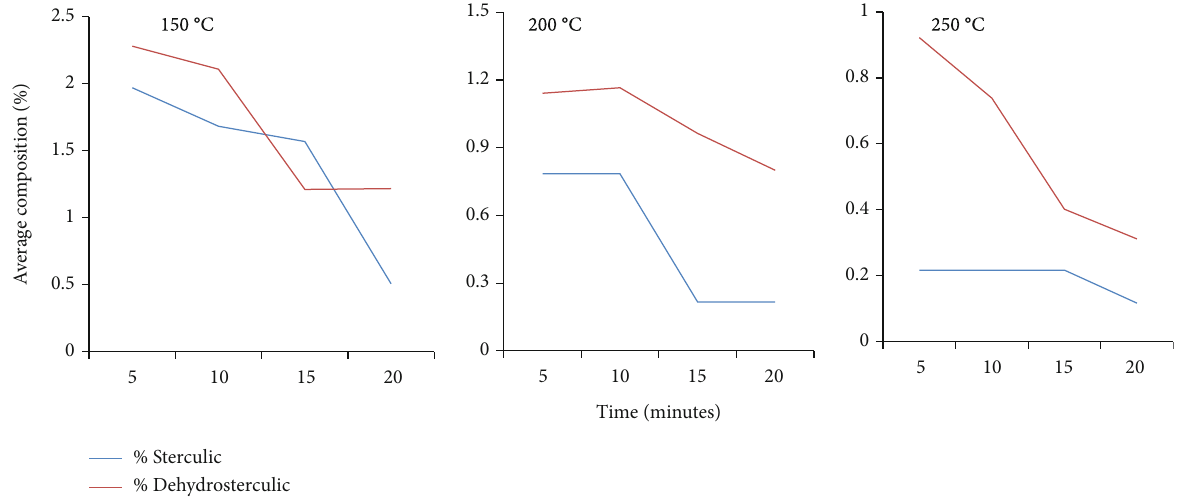
Figure 4: Percentage cyclopropenoid fatty acid composition with a variation of heating time and